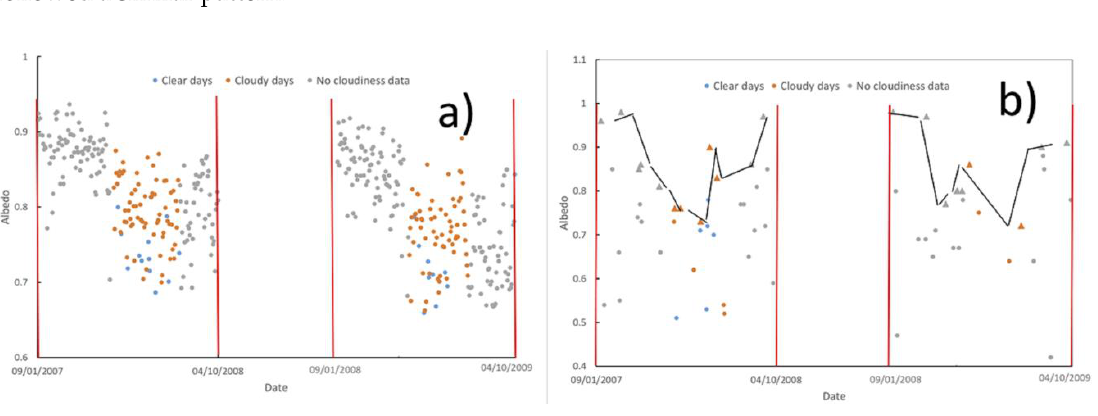
Figure 6. In-situ ( a ) and MOD10A1 ( b ) albedo at JG from September 1 2007 to April 10 2009. In-situ data are calculated as the mean value from 10 h to 14 h LST. Days are classified according to the in-situ cloudiness index, as Clear (blue symbols) or Cloudy (orange symbols). Days with no cloudiness data are represented in grey symbols. Triangles in ( b ) represent the maximum value for every three consecutive data. The trend of MOD10A1 maxima is indicated with a solid black line in ( b ). Red vertical lines indicate, from left to right: 09/01/2007, 04/10/2008, 09/01/2008, and 04/10/2009.